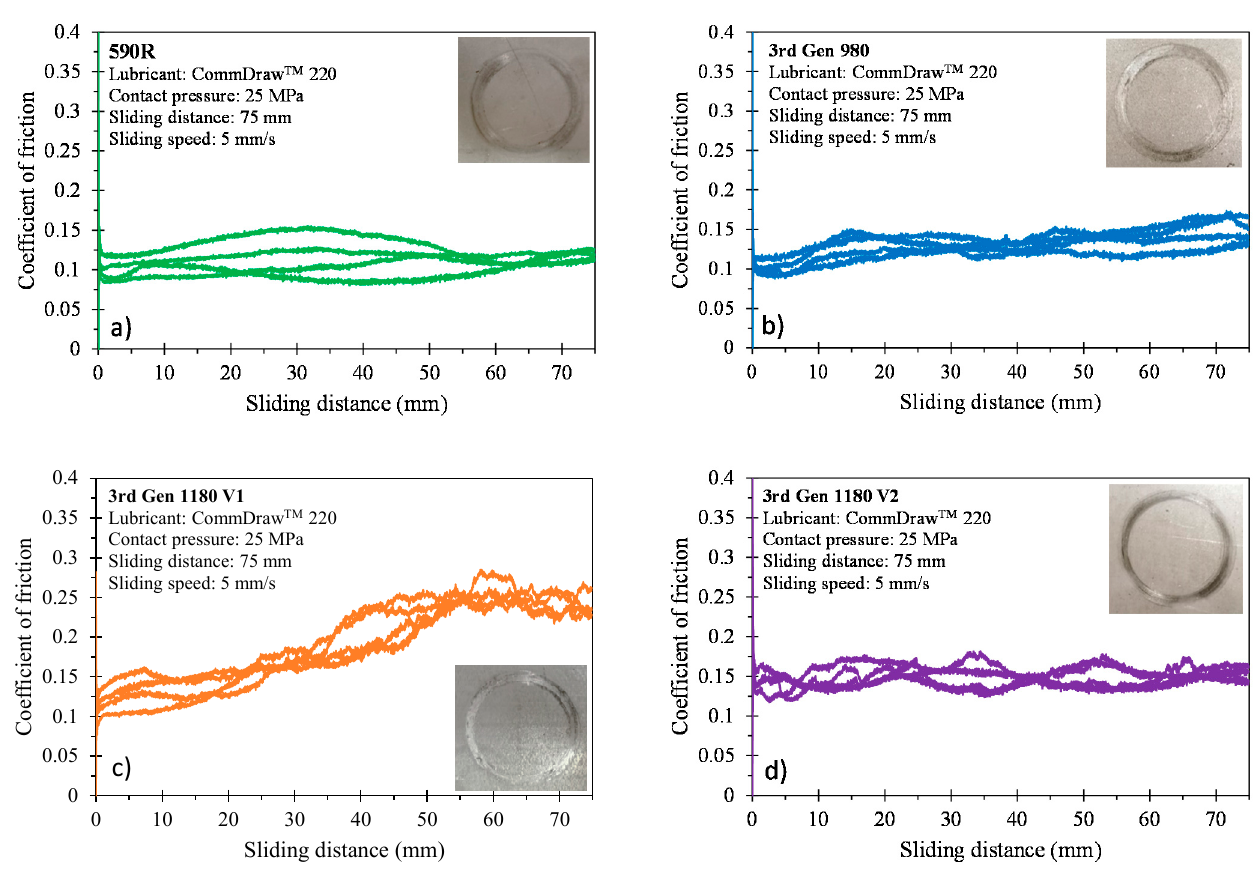
Figure 20. Evolution of the frictional response over the 75 mm sliding distance for the 590R ( a ), 3rd Gen 980 ( b ), 3rd Gen 1180 V1 ( c ) and 3rd Gen 1180 V2 ( d ). Table 8. Surface roughness and coefficient of friction for different steel grades. Note that the friction coefficient was obtained using the lubricant CommDraw TM 220. The numbers in brackets correspond to the standard deviation. Process Parameter Process